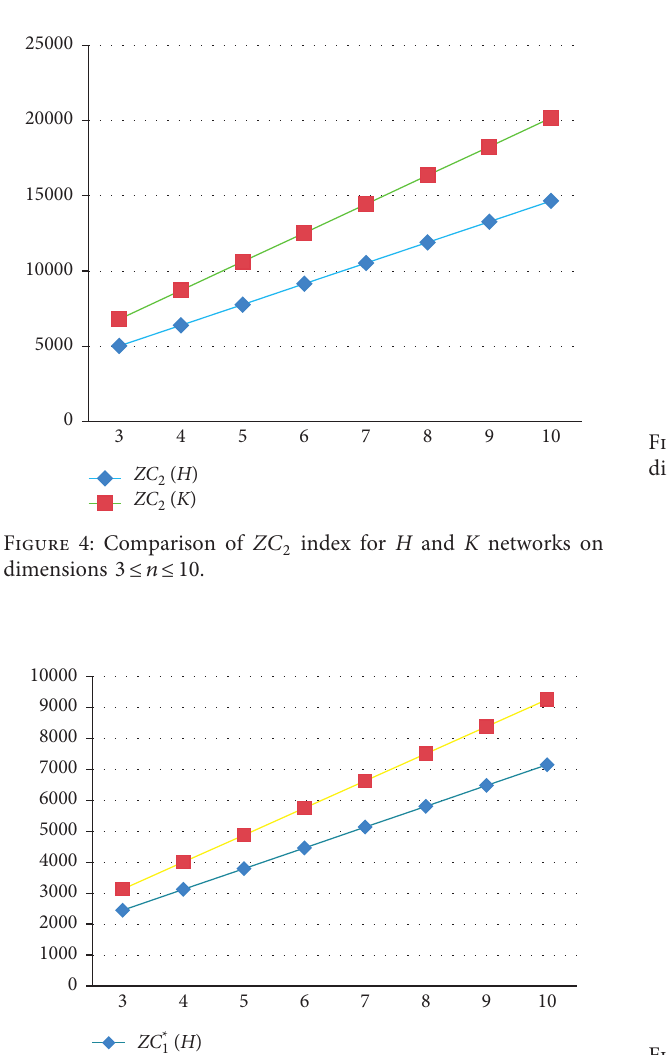
index for H and K networks on 4